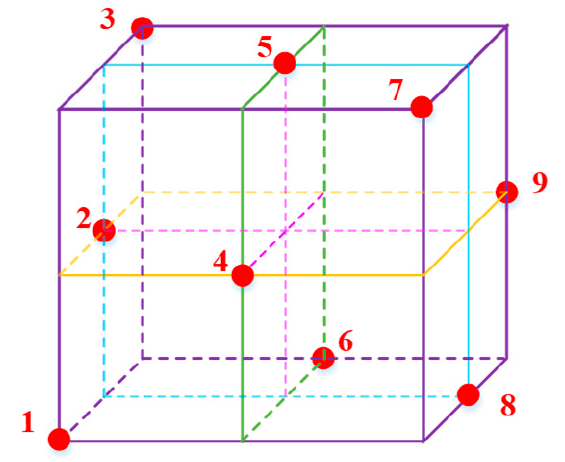
Figure 10. Schematic of orthogonal test design.